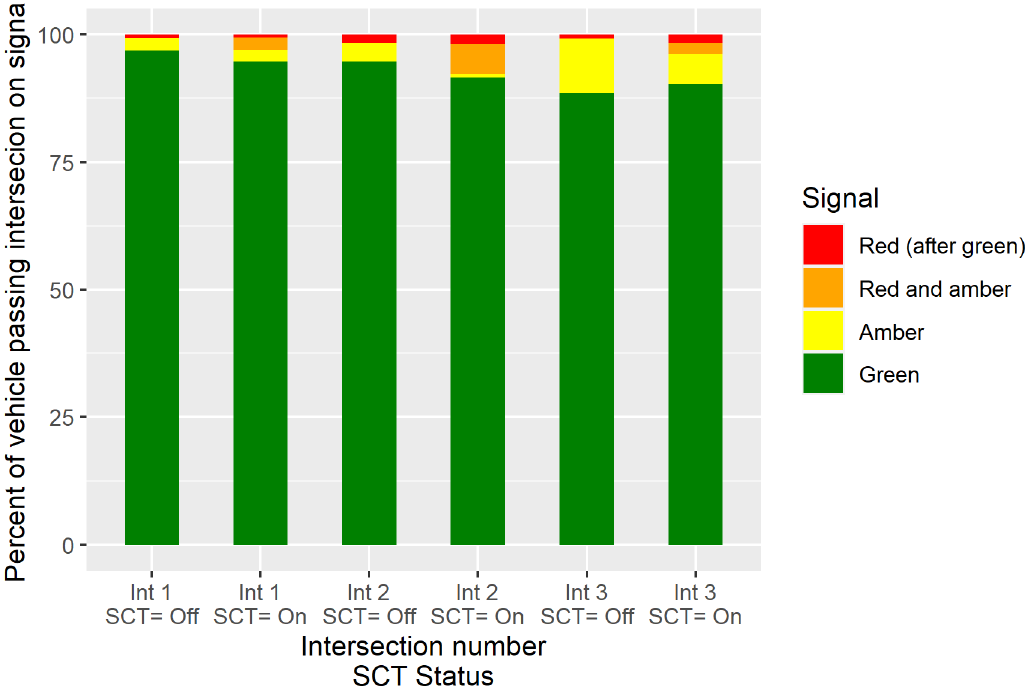
Figure 7. Percentage of vehicle entries on each signal.